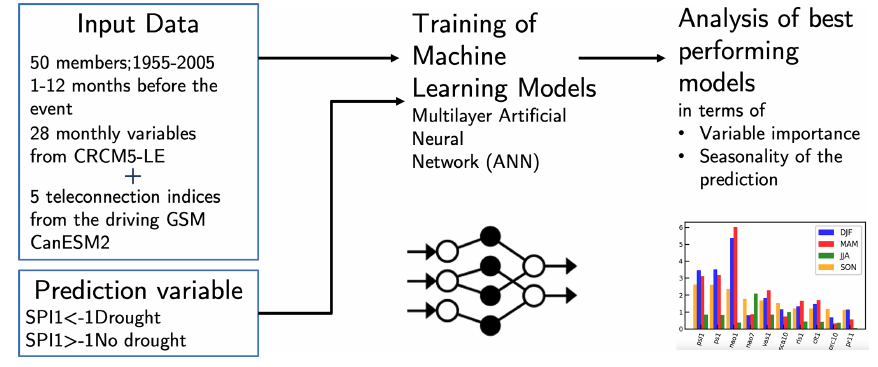
Figure 3. Overview of the proposed methodology. Table 3. Results of ANN training for different values for λ for L2 regularization. λ of 0.001 (bold) is chosen for both domains for subsequent training since the performance of the model with regards to the F1 score has a higher importance for an imbalanced dataset than the pure accuracy. λ Lisbon Munich Train